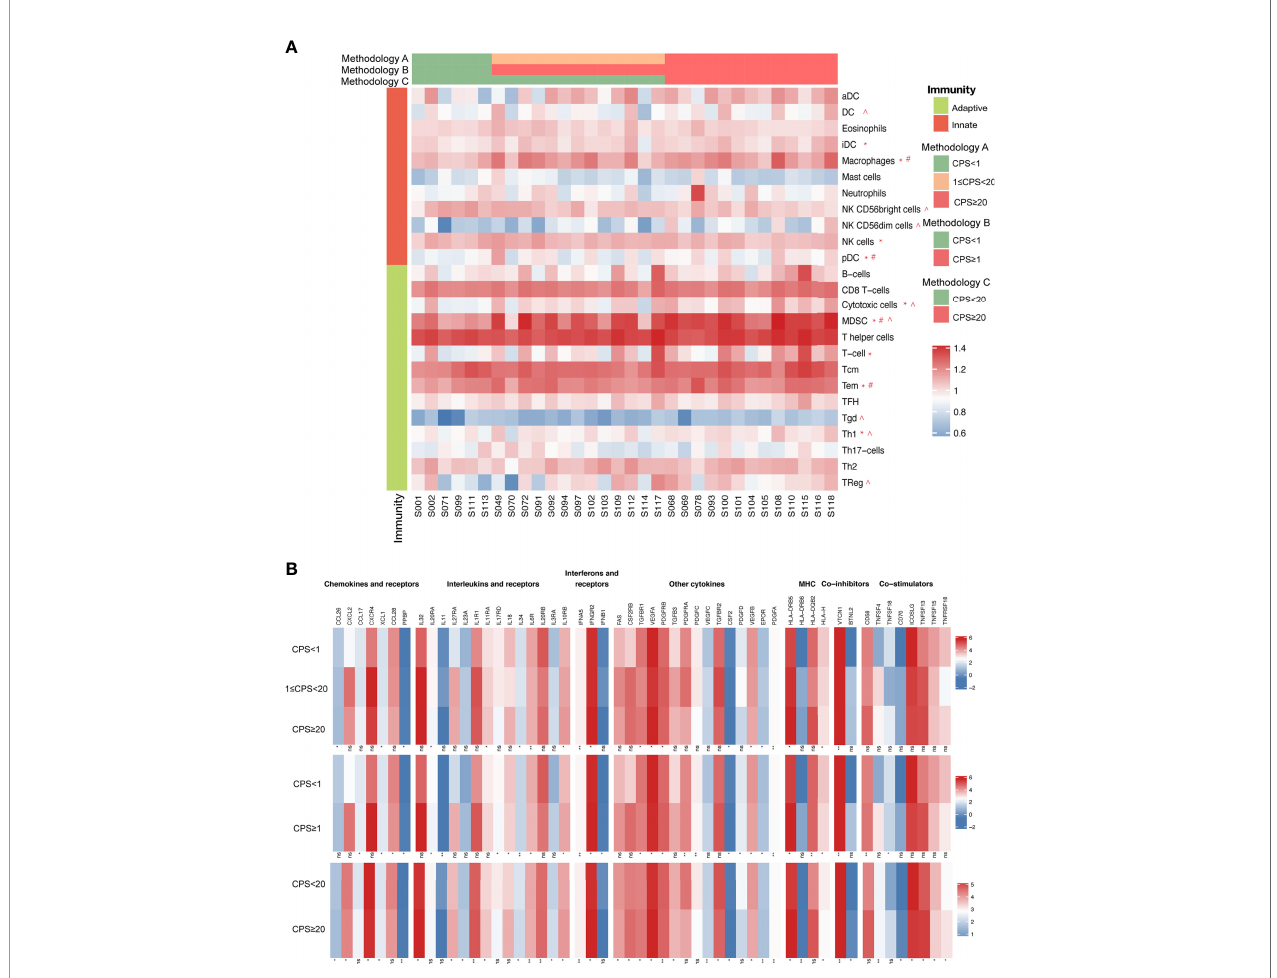
FIGURE 7 | (A) Immune cell marker expression analysis on RNA-sequencing data based on CPS levels. (B) Immune signature analysis based on CPS levels. “ * ” indicates immune cell markers expressed signi fi cantly different classi fi ed by methodology A. “ # ” indicates immune cell markers expressed signi fi cantly different classi fi ed by methodology B. “ ^ ” indicates immune cell markers expressed signi fi cantly different classi fi ed by methodology